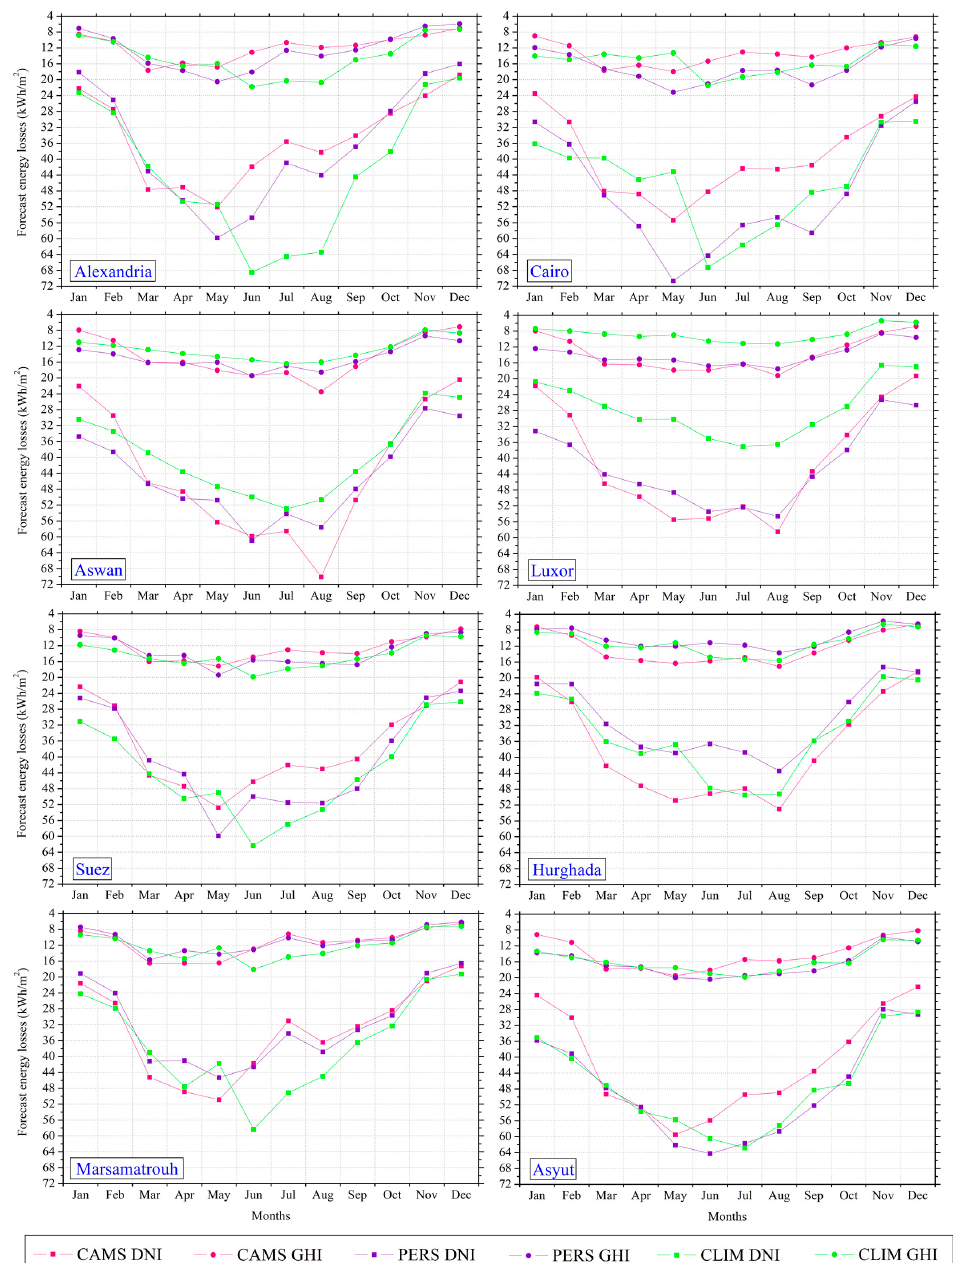
Figure 7. Monthly mean forecast solar energy losses in kWh/m 2 for the regions of ALE, CAI, SUE, HUR, ASW, LUX, MAR and ASY. The AOD forecasting techniques of CAMS, MODIS PERS and MODIS CLIM were applied as inputs to the SENSE producing the solar energy potential in terms of GHI (circles) and DNI (squares). The CAMS produces 1-day forecasts with 3 hour temporal resolution, the PERS uses the MODIS AOD values of the previous day for the 1-day forecast as persistent aerosol conditions and the CLIM uses the monthly mean MODIS AOD values as steady aerosol conditions for every single time step of the whole month.